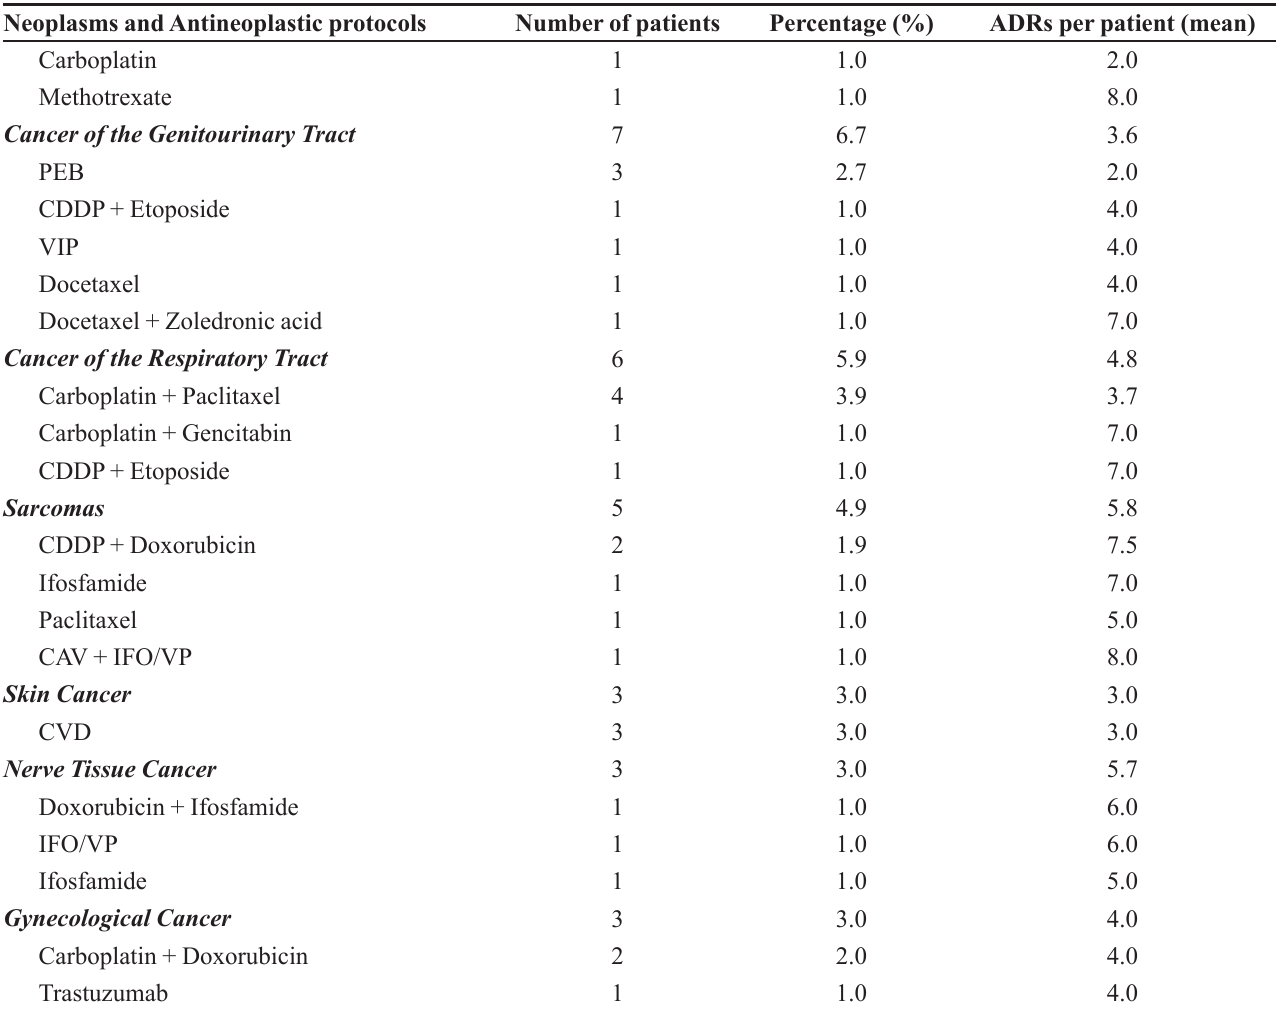
TABLE III - Neoplasms, antineoplastic protocols, and adverse drug reactions (ADRs) of outpatients interviewed in the Chemotherapy Clinic from October to November 2010